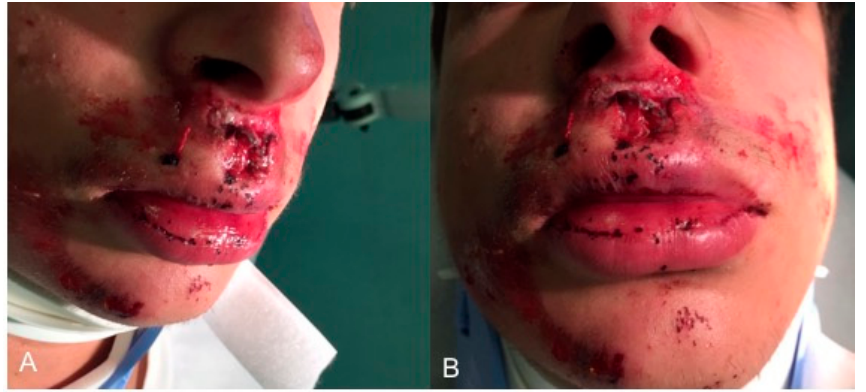
Figure 1. Extraoral facial images immediately after trauma: ( A ) extraoral lateral view; ( B ) extraoral frontal view.